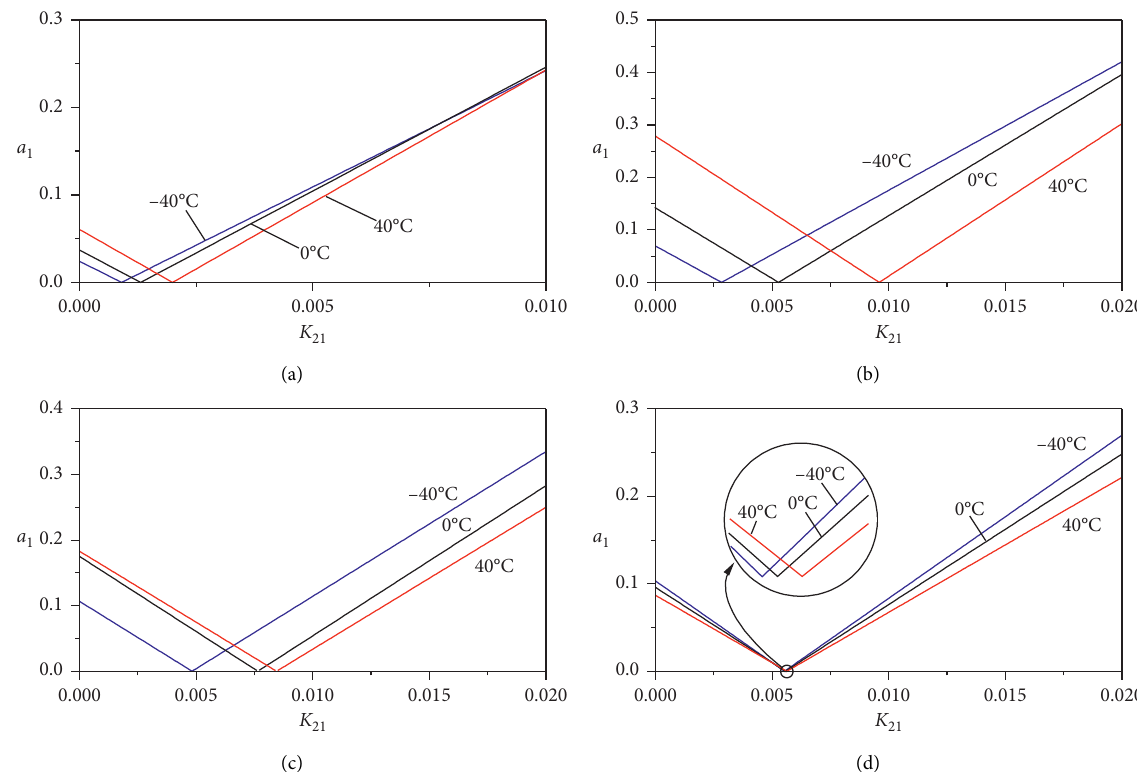
� 0 . 005 in Case (A). when K 1 11